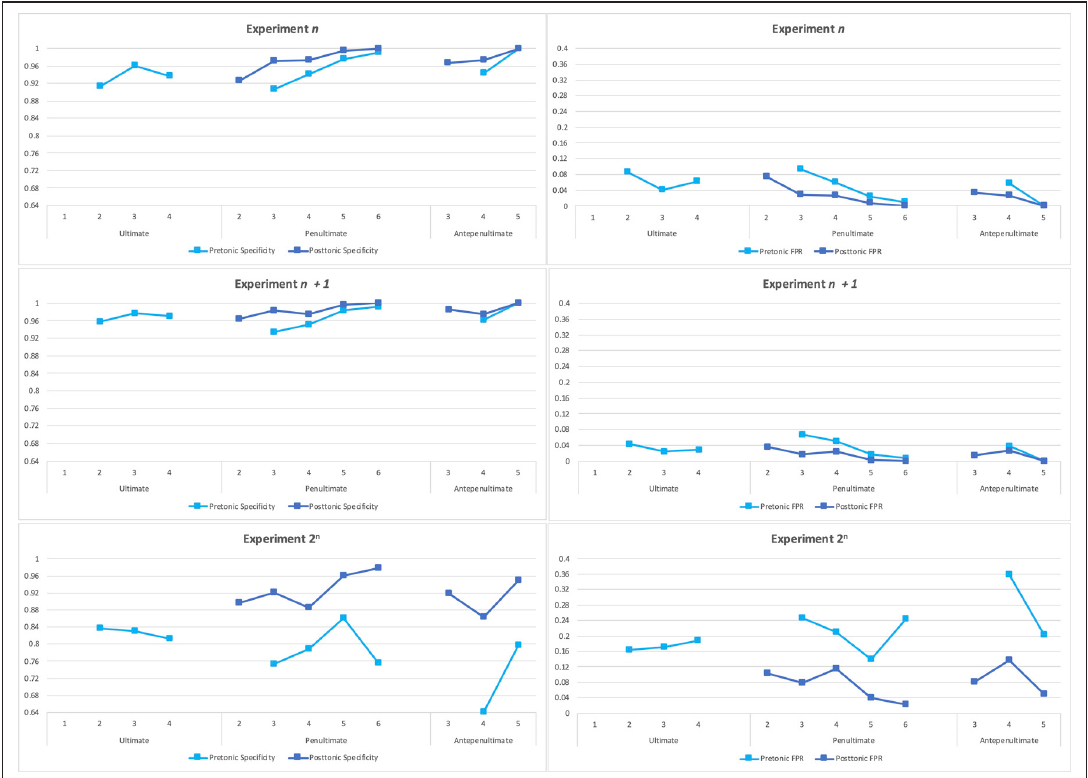
Figure 14: Discriminatory skills for pretonic and posttonic